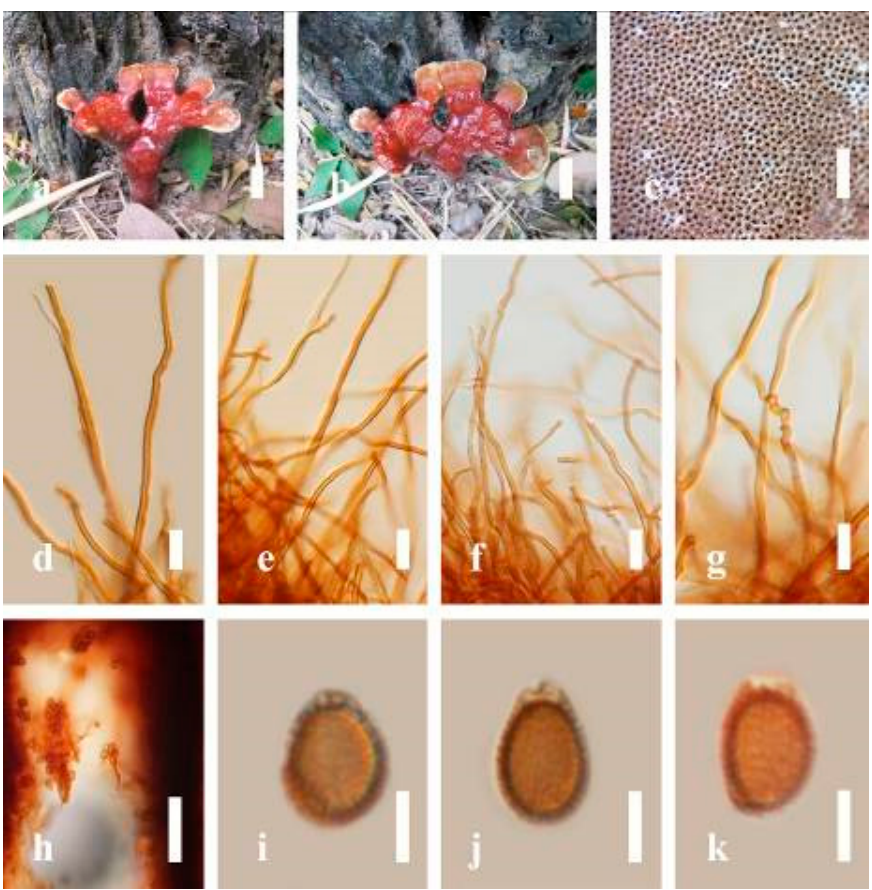
Figure 27. Morphology characteristics of Ganoderma multipileum (MFLU 19 ‐ 2166): ( a , b ) mature basidiomes; ( c ) pore characteristics; ( d ) generative hyphae of context in KOH; ( e – g ) generative. skeletal and binding hyphae of context in KOH; ( h ) basidiospores with tube layers; ( i – k ) basidio ‐ spores in KOH. Scale bars: ( a , b ) = 3 cm, ( c ) = 1000 μ m, ( d – g ) = 20 μ m, ( h ) = 50 μ m, ( i – k ) = 5 μ